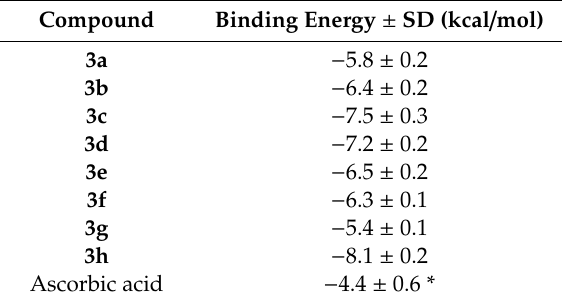
Table 4. Binding energies recovered during docking with respect to the studied ligands. The calculation results were averaged over four di ff erent structures of the same 2y9x protein available in the same PDB record; the corresponding standard deviations are given.